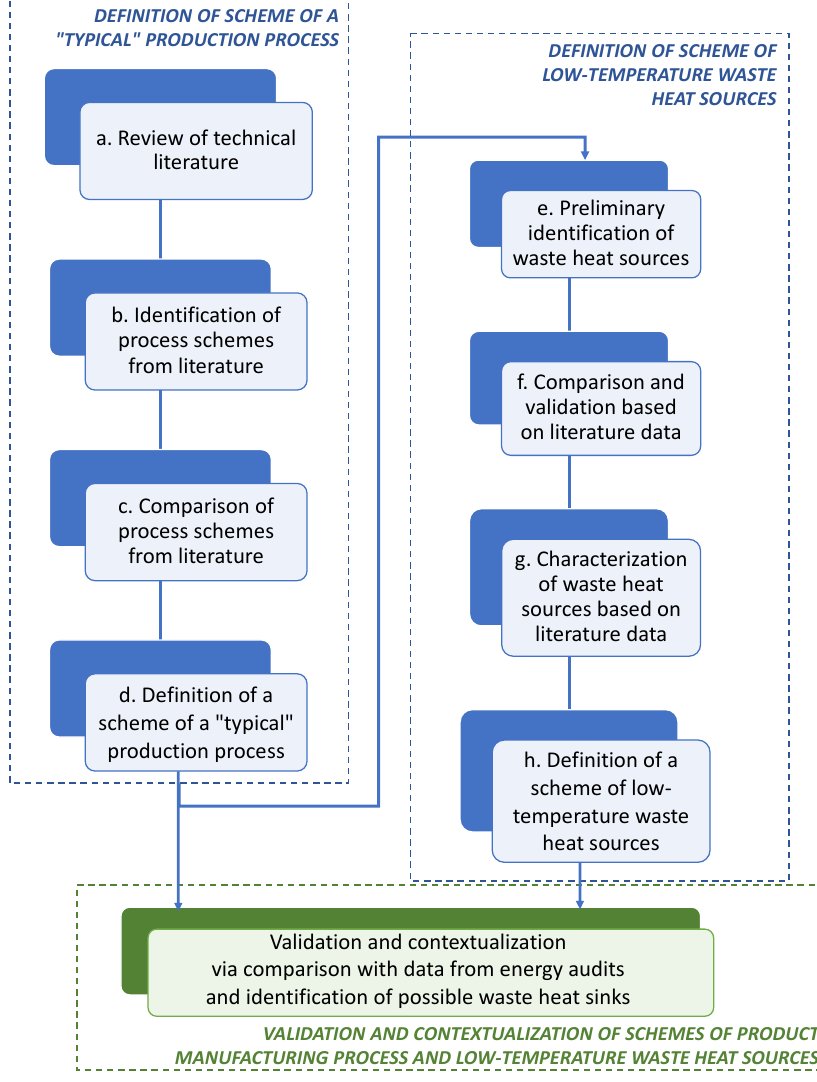
Figure 1. Methodology for the identification and characterization of the schemes of product manufac- turing process (steps ( a – d )) and low-temperature waste heat sources within the industrial processes (steps ( e – h